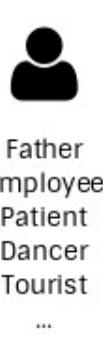
Figure 2. User’s face in different stages.